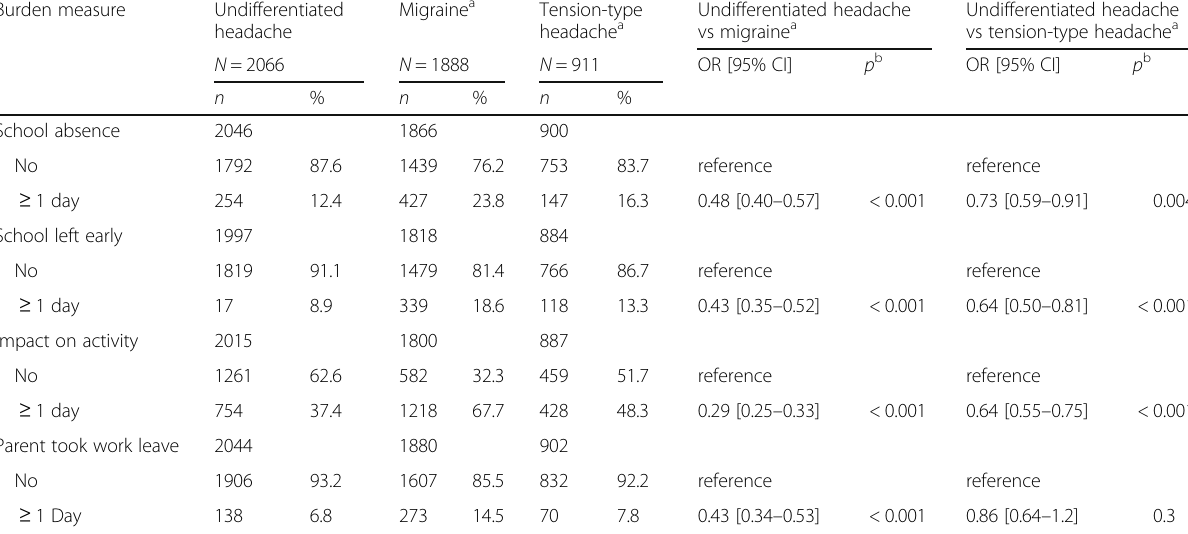
Table 3 Burden of undifferentiated headache, migraine and tension-type headache (preceding 4 weeks) Burden